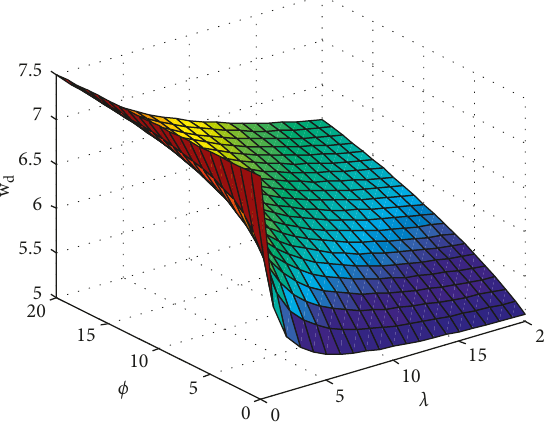
Figure 7: Impacts of dual-fairness concern on wholesale price.